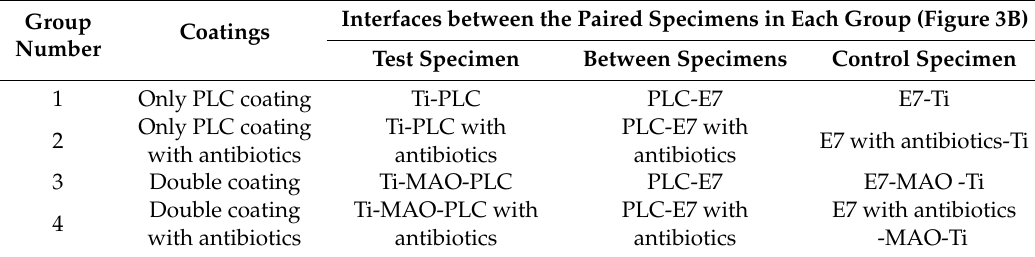
Table 1. The interfaces in each group for tensile